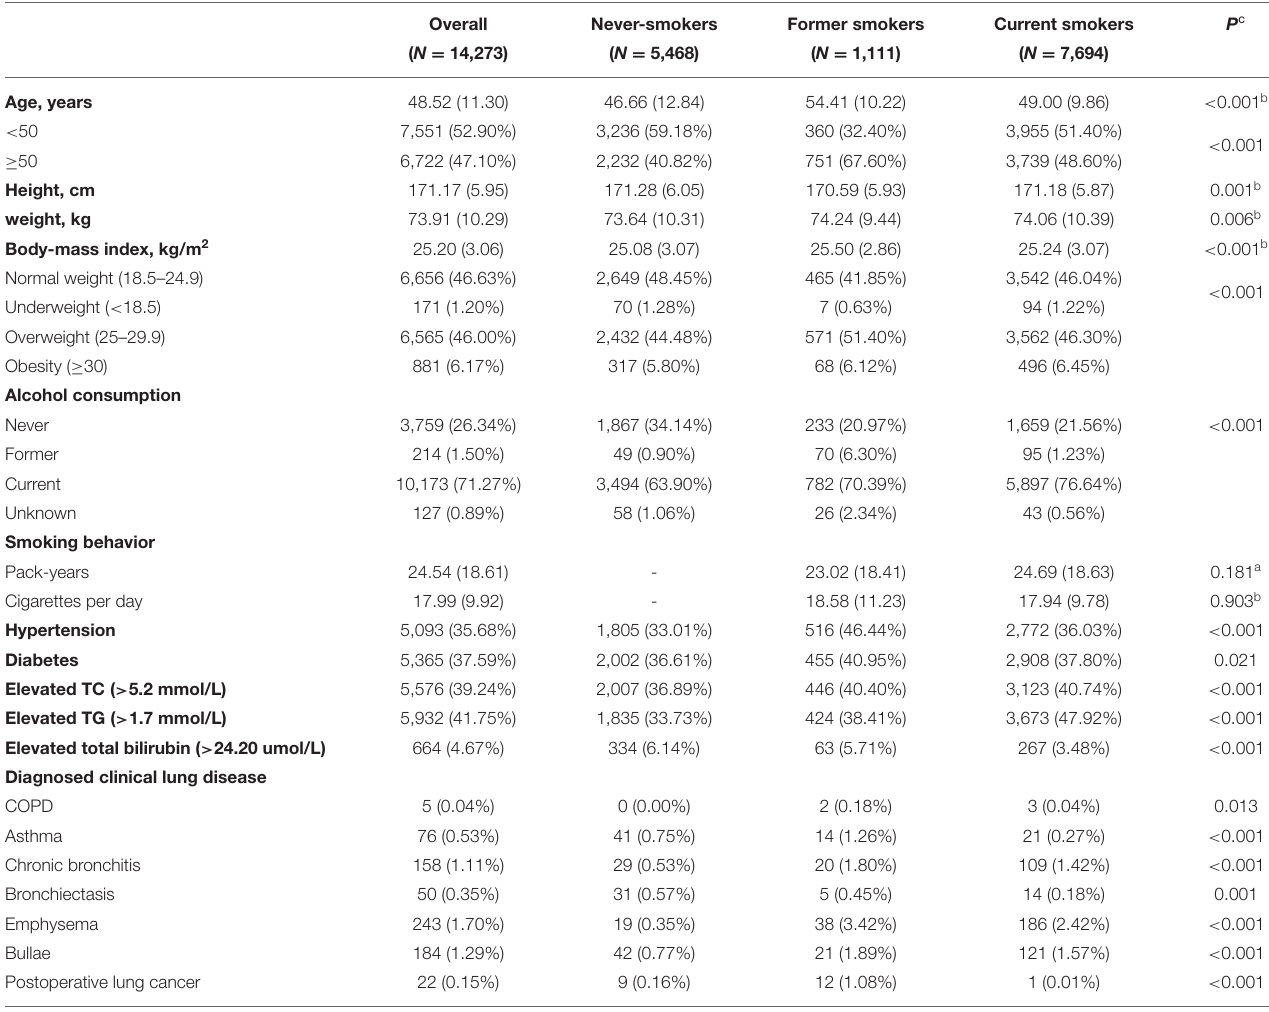
TABLE 1 | Baseline characteristics of 14,273 male participants according to smoking status in the cross-section analysis. Overall